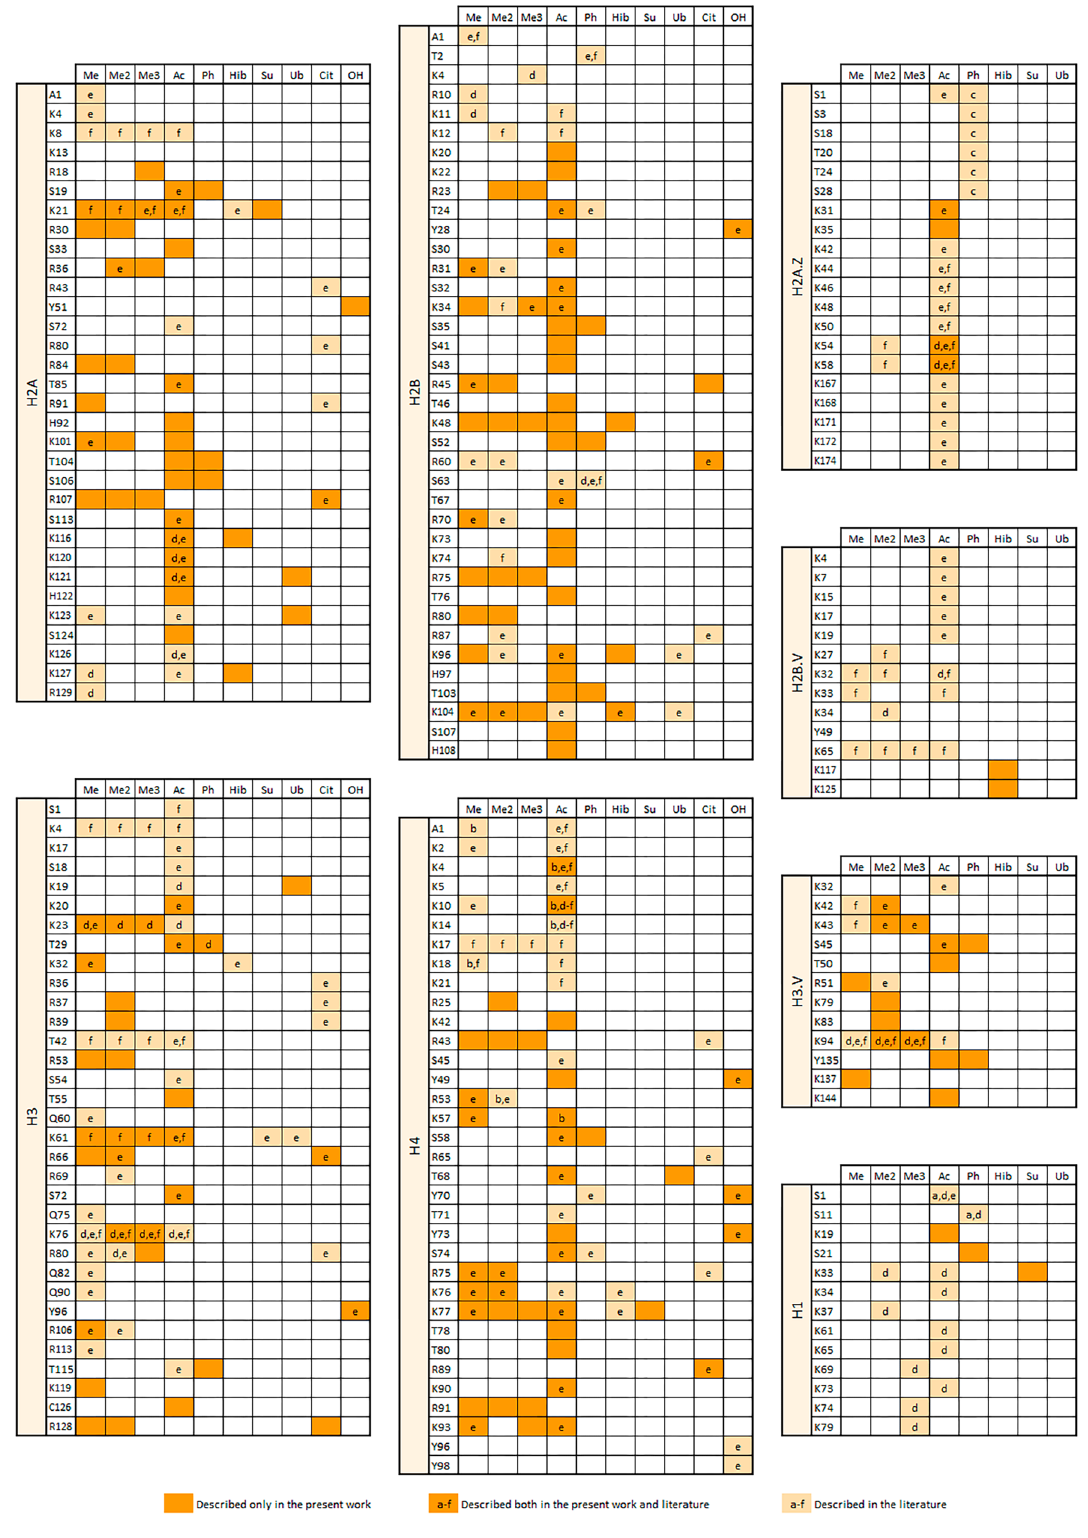
Figure 4. PTM sites identified in the present work and previously reported in the literature (a- da Cunha et al., 2005 6 ; b- da Cunha et al., 2006 7 ; c- Marchini et al., 2011 8 ; d- de Jesus et al., 2016 9 ; e- Picchi et al., 2017 11 and f- de Lima et al., 2020 10 ). Me: methylation, Me2: dimethylation; Me3: trimethylation; Ac: acetylation; Ph: phosphorylation; Hib: 2-hydroxyisobutyrylation; Su: succinylation; Ub: ubiquitination; Cit: citronylation; OH: hydroxylation. Noteworthy, as described for humans and other eukaryotes, T. cruzi histones lose the initial methionine during protein